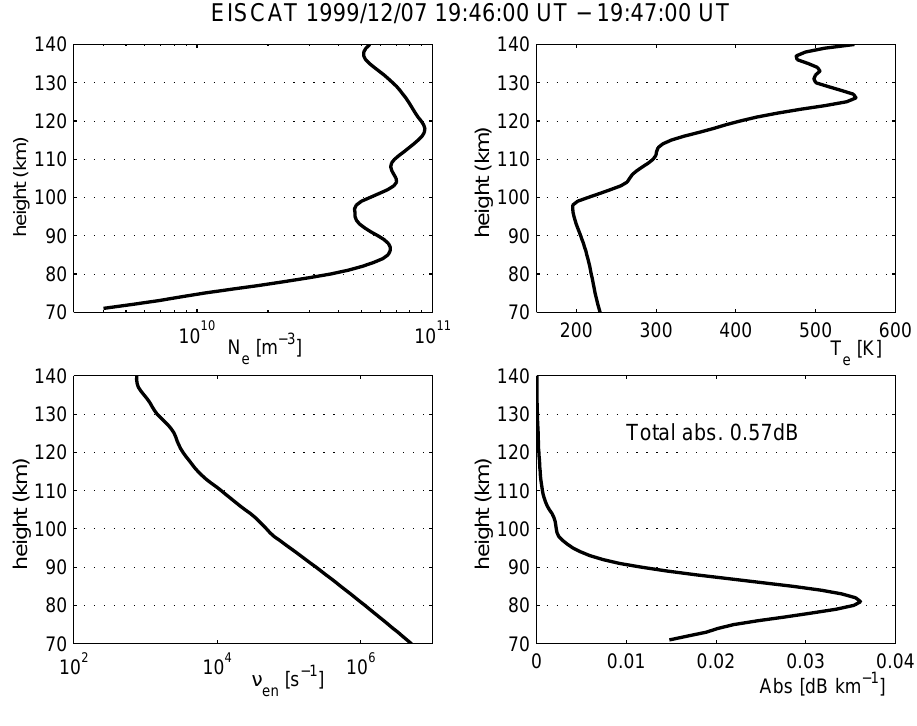
Fig. 4. Examples of altitude profiles of electron density (top left), electron temperature (top right), electron-neutral collision frequency (bottom left) and calculated incremental absorption for the 70 to 140km altitude in Event 1. The total absorption is obtained by integrating the incremental absorption over